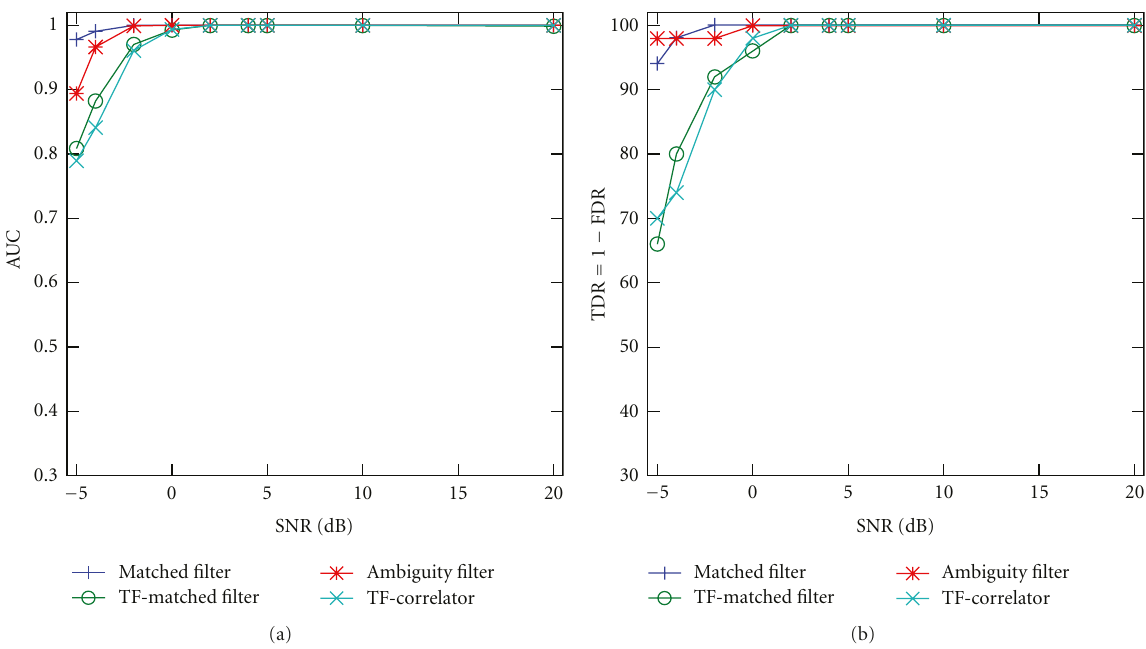
Figure 5: Results for detecting signals in white Gaussian noise with lower-energy harmonics. At a specific signal to noise ratio (SNR), 50 epochs of noisy signal and 50 epochs of noise are used to generate the receiver operator characteristic curve. From this curve, the area under the curve (AUC) and point of equal sensitivity and specificity (TDR = 1 − FDR) are